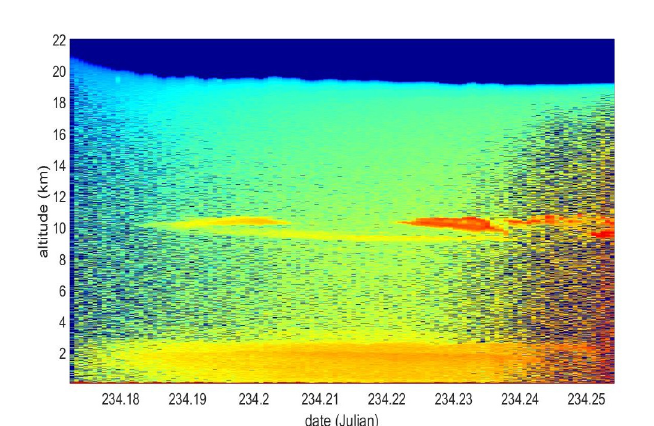
Fig. 2 Vertical cross section of the range-corrected at- tenuated backscattered signal (arbitrary unit) averaged over one minute for a leg of 2 hours LT on August 23